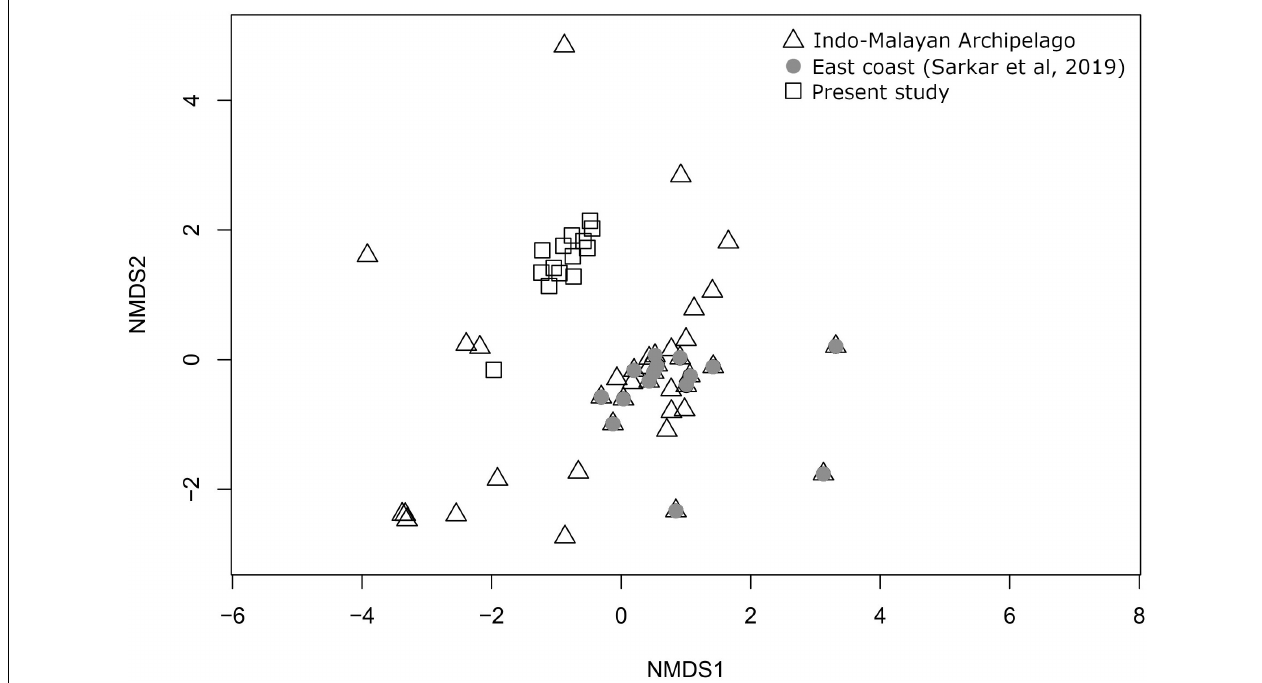
FIGURE 8 | Ordination plot using non-metric multidimensional scaling, based on Bray–Curtis distance calculated from a matrix of marine bivalve species occurrence from Indo-Malay Archipelago, literature-based data of east coast from Sarkar et al. (2019) and the present study.